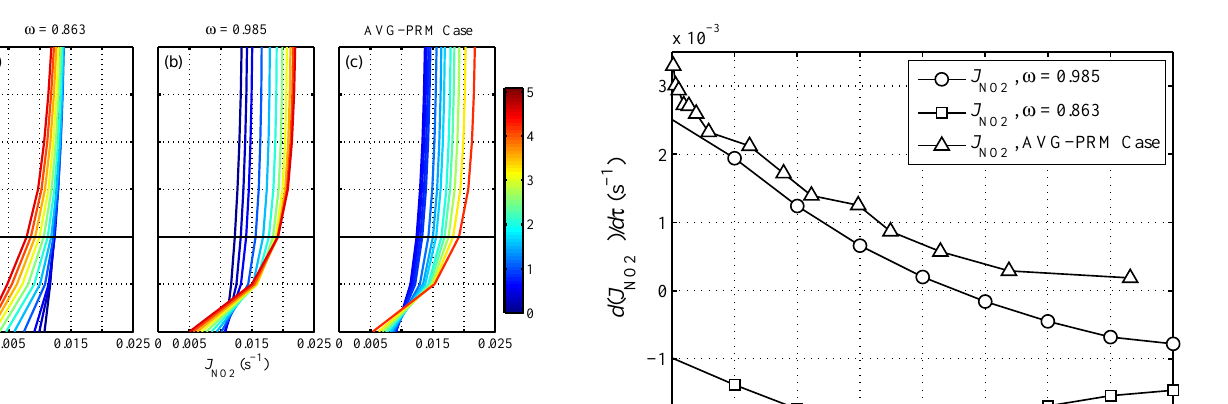
Figure 7. Altitude profiles of J NO Fig. 6. Colors represent the value of τ , as expected. The black lines indicate the height of 2km.